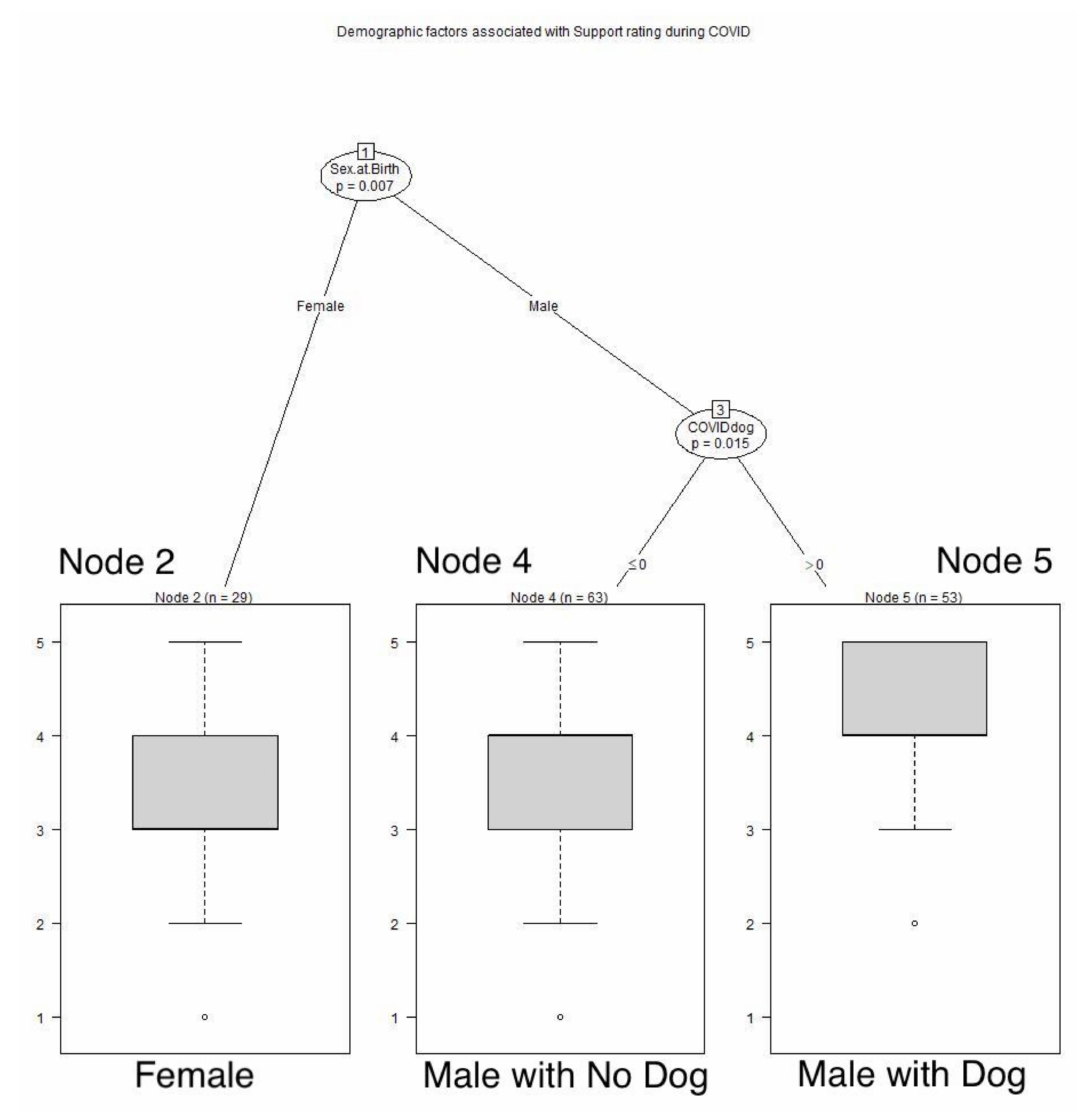
Figure 9. Demographic factors associated with ratings of human support during COVID. Men reported greater human support than women, and men with dogs gave still higher ratings of their human support than men without dogs: Node 2: x − = 3.345, SD 0.934; Node 4: x − = 3.683, SD 0.9809; Node 5: x − = 4.094, SD